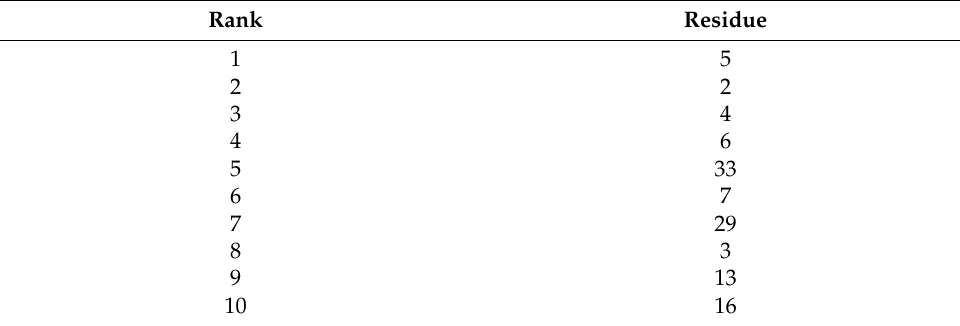
Figure 1. Overall ranking: Using the algorithm developed, a dot plot was created for the rank compared to the residue. This dot plot contains the final results of the methods combined. As shown, the signaling domain contains many of the key residues. Each point is labeled with the residue number. Table 8. Conclusion of Best Ranking Angles.